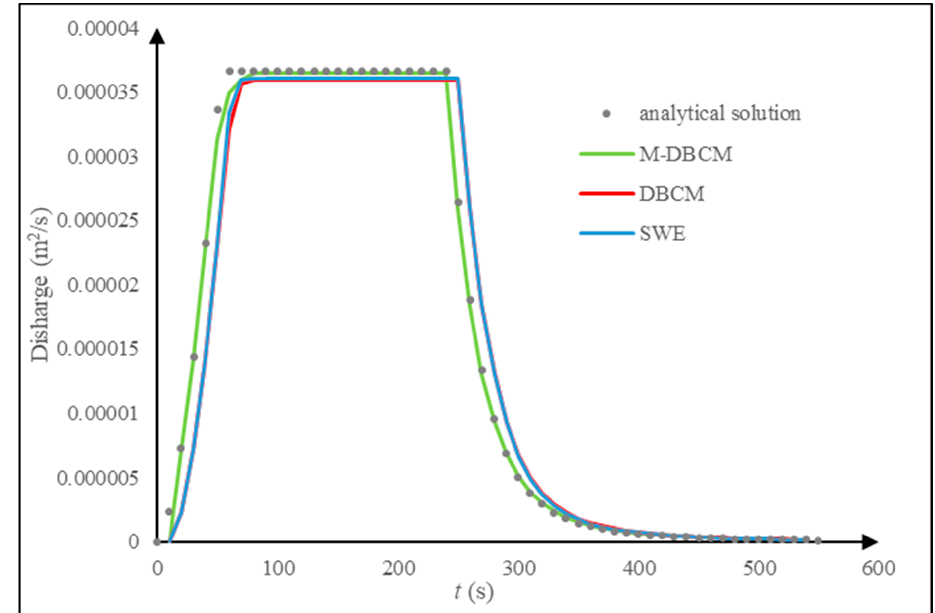
Figure 7. The discharge hydrographs obtained from different models.